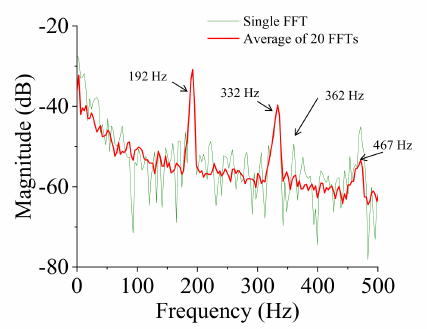
Figure 14. Spectral data of the healthy fully-assembled TPS panel.